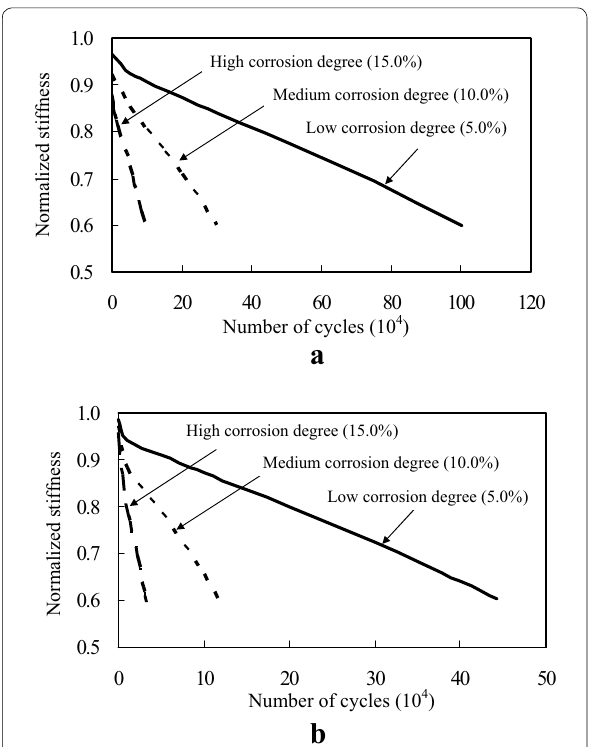
Fig. 12 Normalized stiffness degradation versus number of cycles: a a/b 0.62, b a/b 0.83. = =